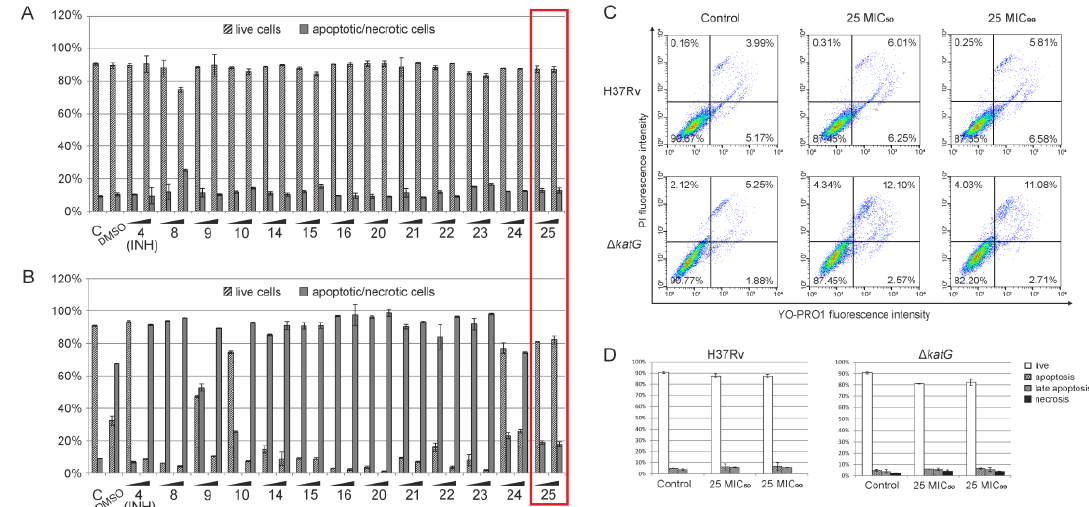
Figure 7. Flow cytometry analysis of apoptosis/necrosis in HaCaT cells after treatment with compounds. Cell toxicity was analyzed using the apoptosis/necrosis assay by flow cytometry. The cells were simultaneously incubated with the compounds for 24 h at the desired concentrations that were estimated previously for both wild-type ( A ) and mutant strains ( B ), corresponding to the MIC 50 and MIC 99 values. ( C ) Simultaneous flow cytometry analysis of apoptosis/necrosis in cells treated with compound 25 at concentrations determined as MIC 50 and MIC 99 for the wild-type and mutant strains. ( D ) Flow cytometry data for compound 25 were collected and plotted on bar graphs. Data are presented as mean ± SD.